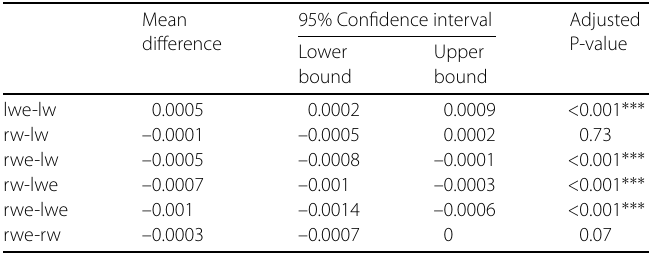
Table 10 ANOVA results to test for correlation of political orientation and extremity with positive and negative emotions Degree of Sum of square Mean square F value Pr (> F ) freedom Positiveemotion : Political orientation 1 0.000003 0.0000026 11.24 0.001 ∗∗ Political extremity 1 0.000017 0.0000167 73.11 <0.001 ∗∗∗ 0.003962 0.0000002 0.000001 12.08 0.001 ∗∗ Political extremity 1 0.000007 0.0000074 73.17 <0.001 ∗∗∗ Residuals 19,997 0.001757